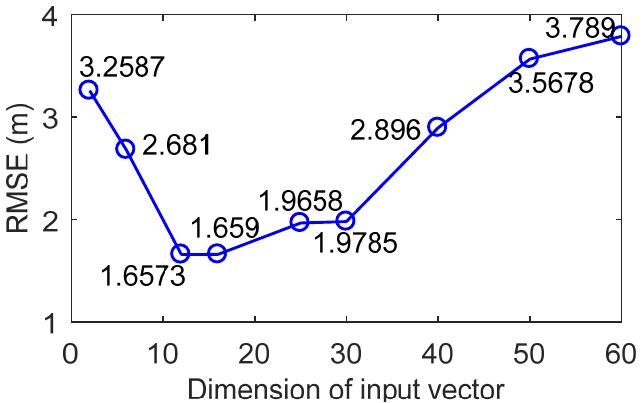
Figure 10. Changes in nowcasting accuracy depending on the input vector dimension.